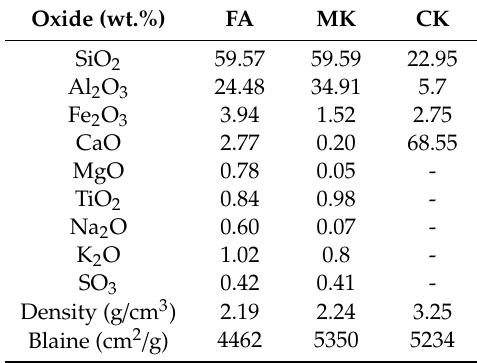
Table 1. Chemical composition and physical properties of fly ash (FA), metakaolin (MK), and clinker (CK), obtained while using X-ray